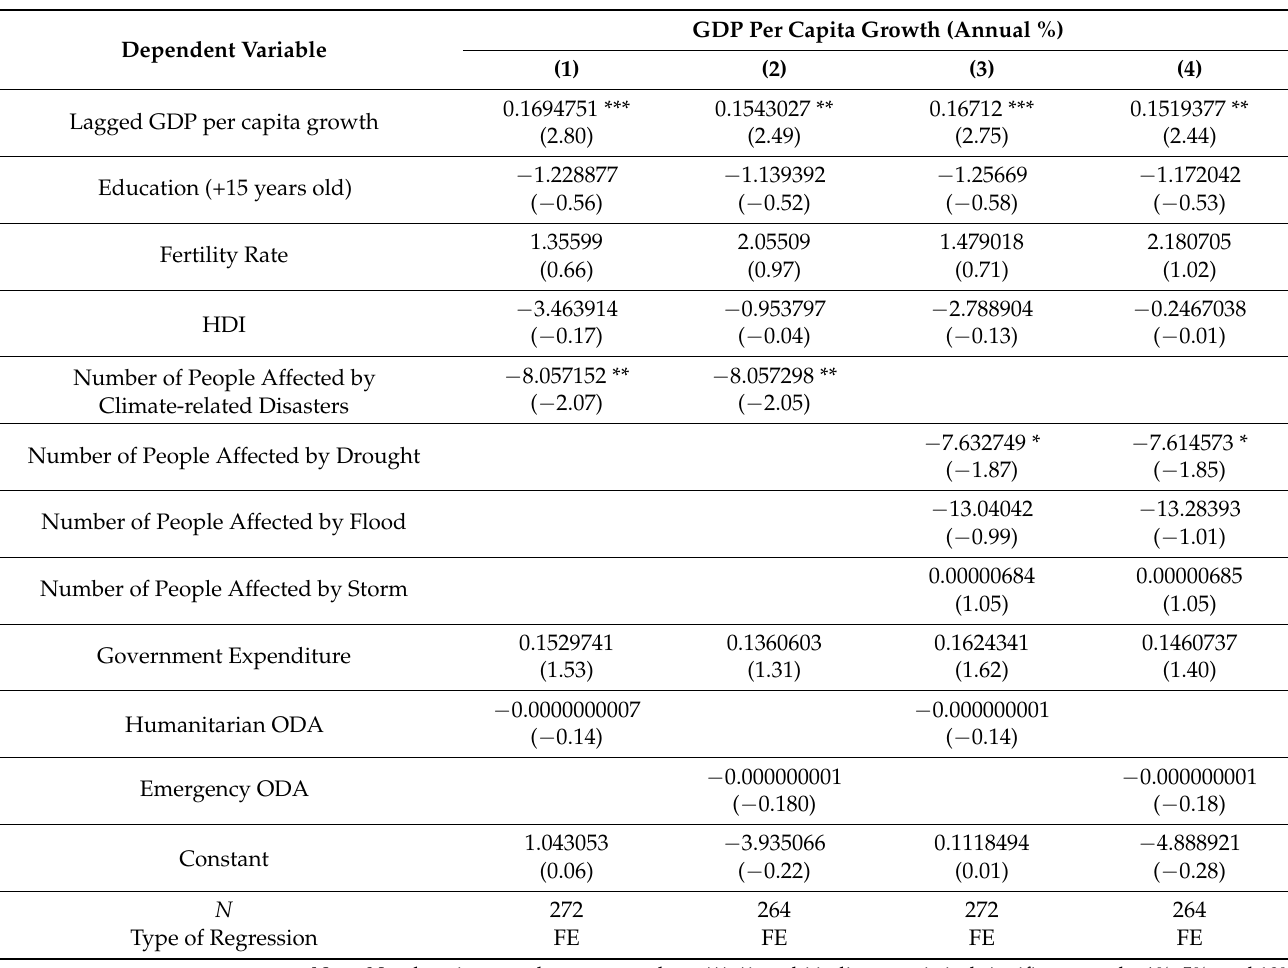
Table 2. Economic Growth Impacts by Climate-related Disasters and